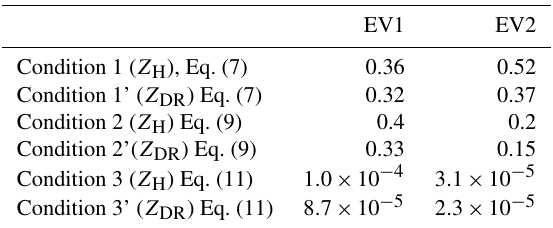
Table 2. Verification of the three analytical conditions derived in Sect. 2 for the two case studies. Conditions 1, 2 and 3 correspond to Eqs. (7), (9) and (11) evaluated with Z H , while conditions 1’, 2’ and 3’ are evaluated with Z DR